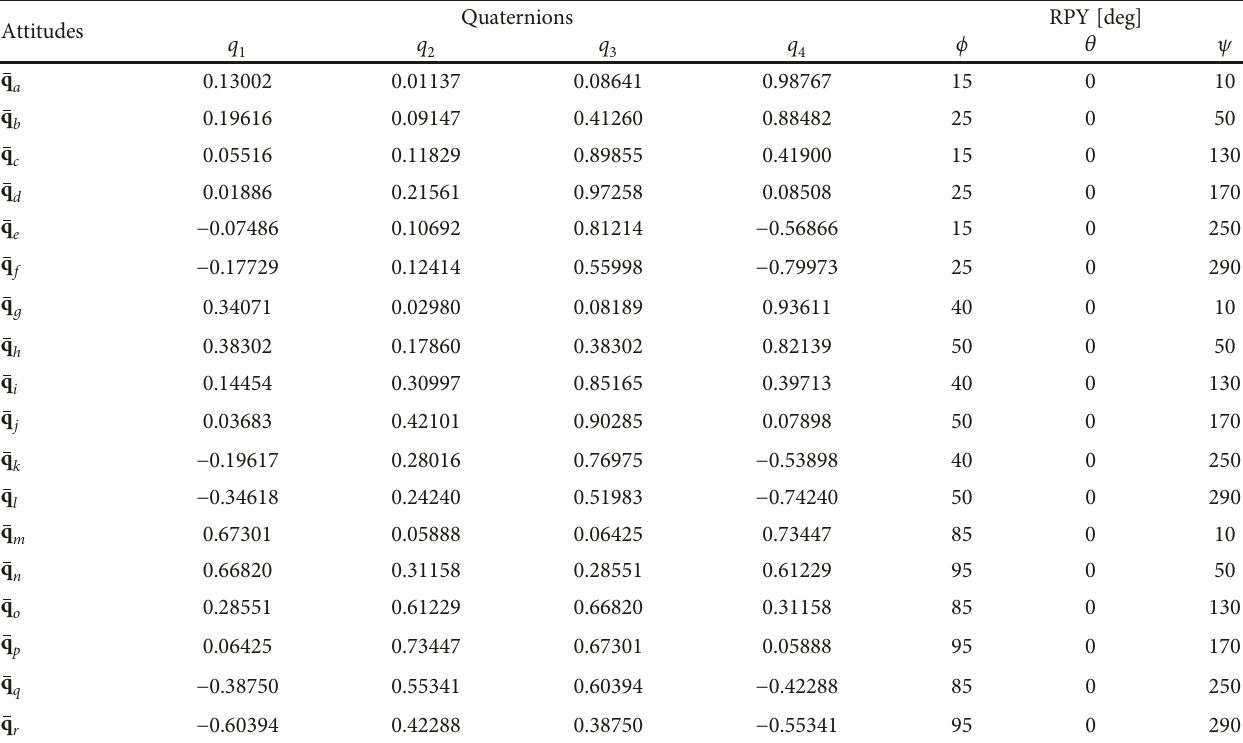
Table 1: Target attitudes used in the